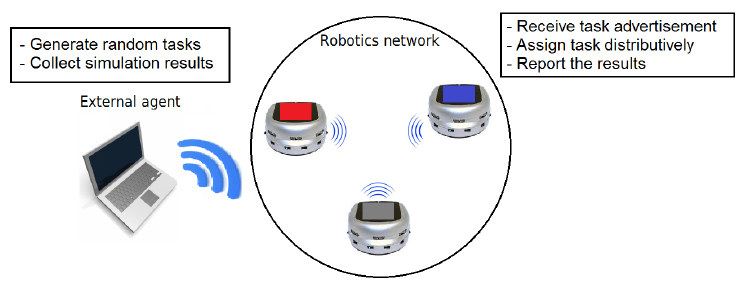
Figure 7. Network schematic diagram of the simulation experiments.